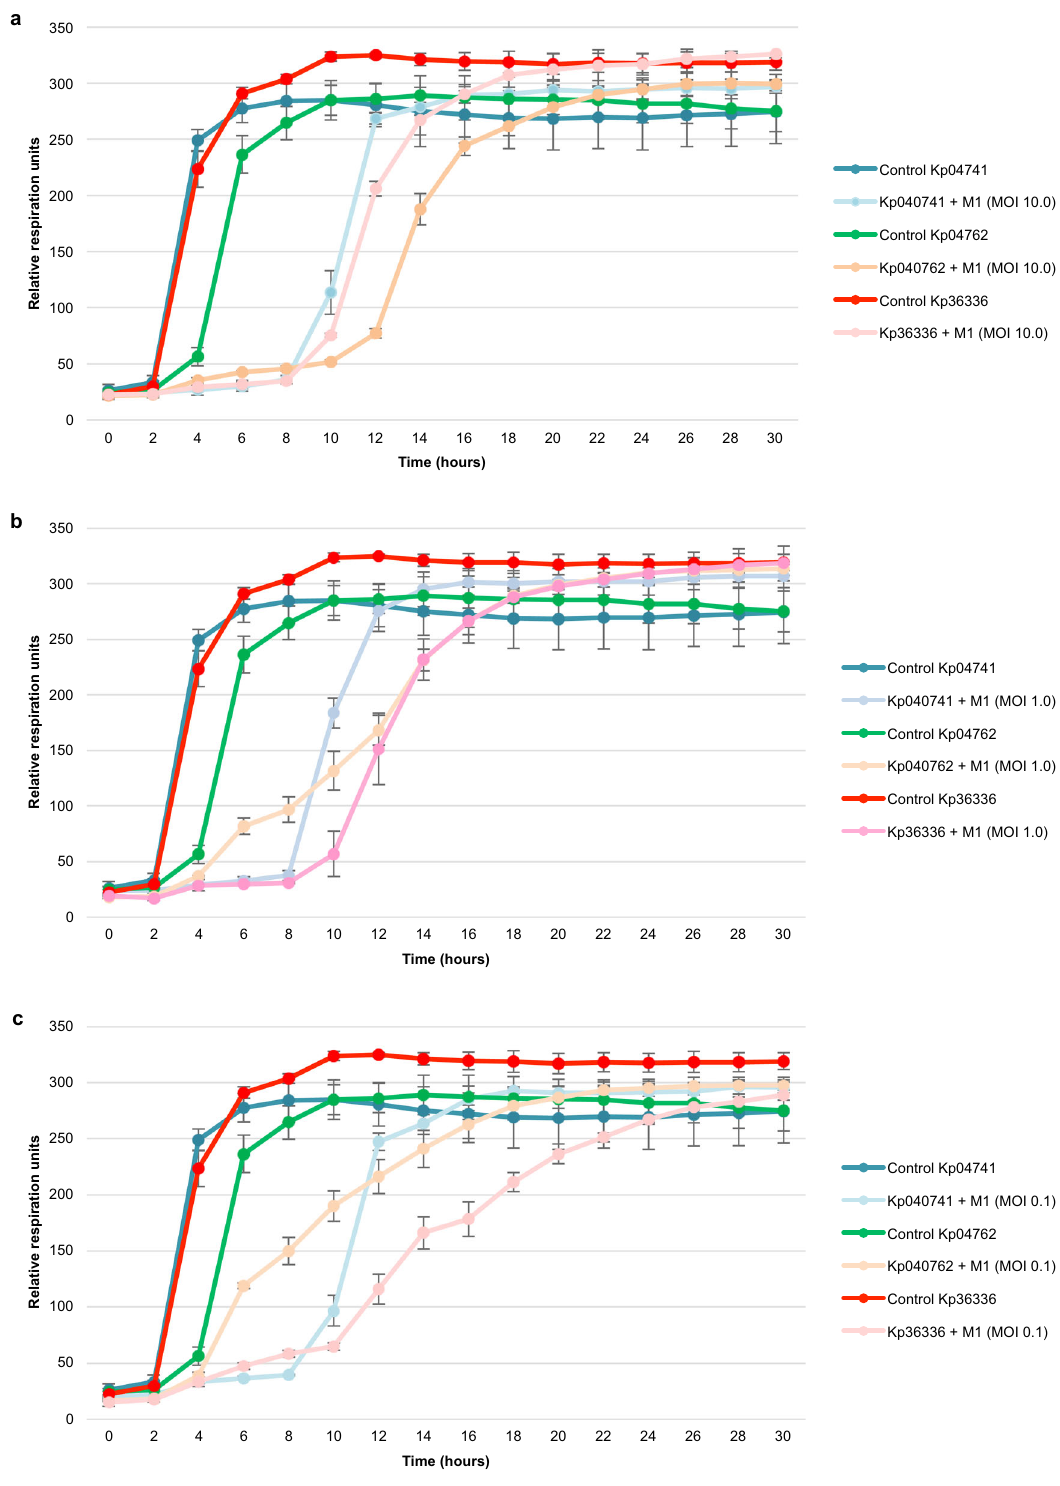
Fig. 6 Pre-adapted phage M1 activity. The activity of pre-adapted phage M1 against Klebsiella pneumoniae isolated on day 170 (isolates Kp04741and Kp04762) and day 702 (isolate Kp36336) postinjury were determined. Phage activity was measured at different multiplicities of infection (MOI): MOI 10.0 ( a ), MOI 1.0 ( b ), and MOI 0.1 ( c ). Controls consisted of the K. pneumoniae isolates without phages. The curves represent bacterial proliferation (cellular respiration). Results are presented as mean values of biological replicates ( n = 3) with error bars representing the standard deviations of the means. Source data are provided as a Source Data fi